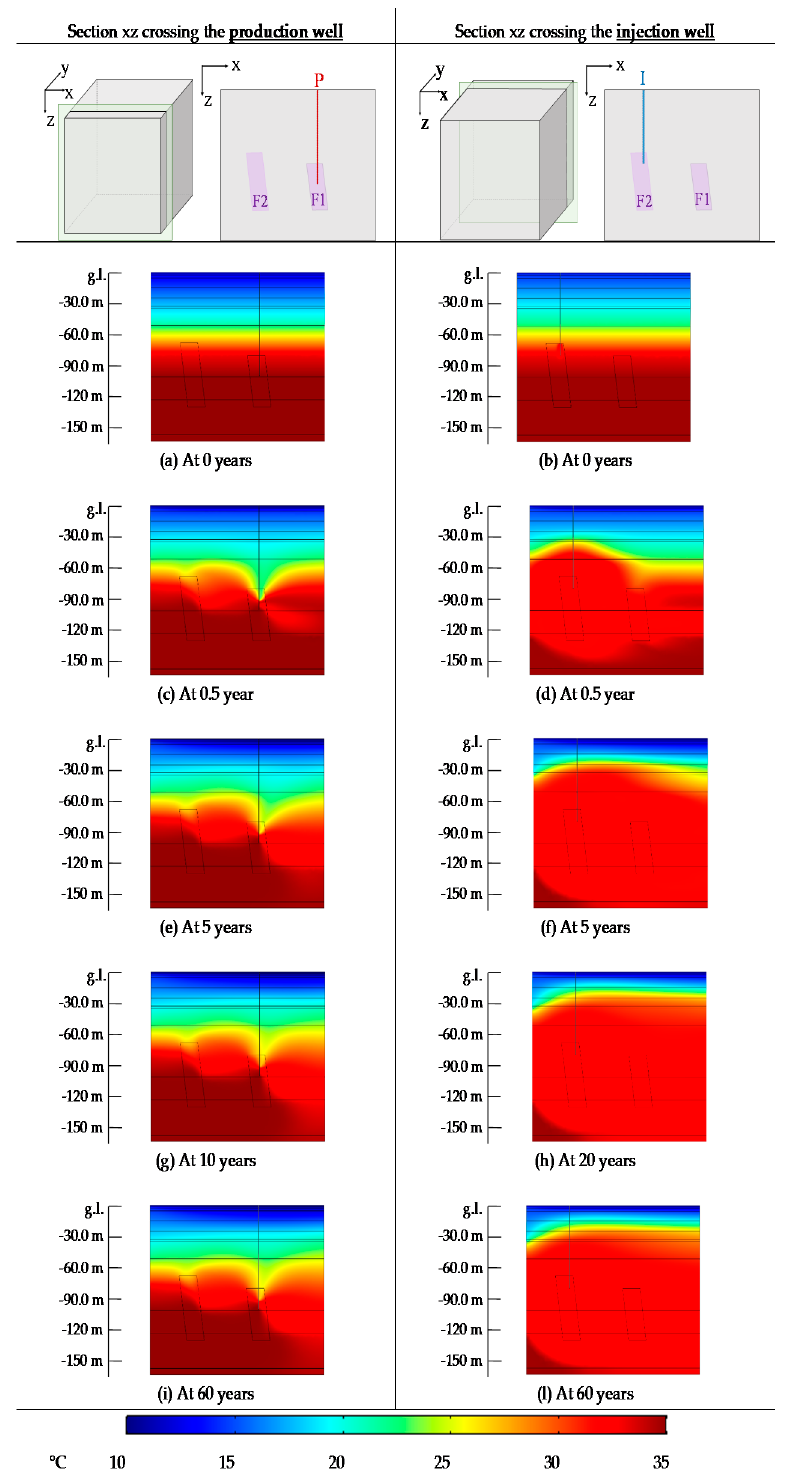
Figure 8. Temperature field of the sections xz crossing the wells, at different times, for Case 2 (double faults).